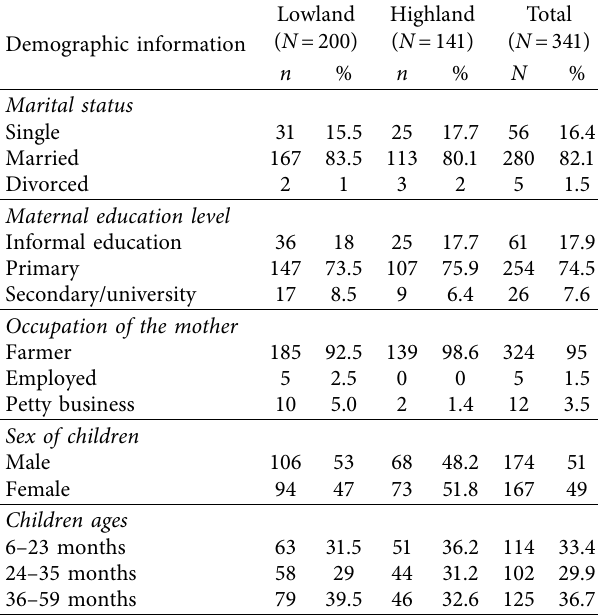
Table 1: Demographic characteristics of the studied population in Kilosa District ( N �